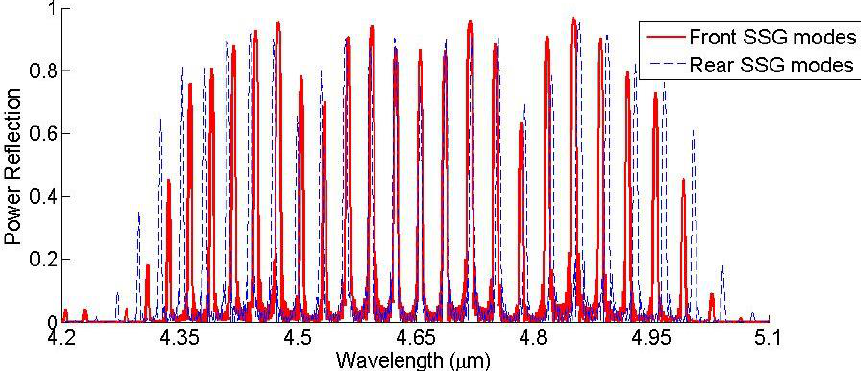
Figure 3. The reflection spectrum of the designed front and rear SSG sections for 4.65 µm